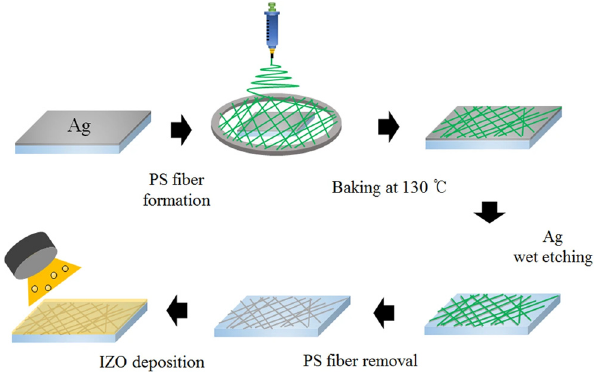
Figure 3. Schematic illustration of the fabrication procedure of Ag fiber/IZO composite electrodes [35].